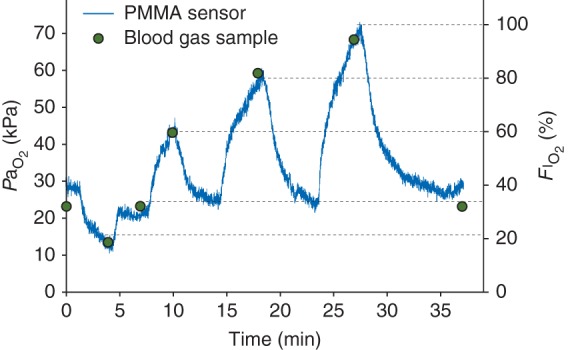
Arterial Po2 responses to FIO2 step changes in one anaesthetized animal (pig) are plotted against time (sampling rate=10 Hz). The blue line shows PaO2 recorded by the PMMA sensor, the circles show results from arterial blood gas sampling at 0, 4, 7, 10, 18, 27, and 37 minutes; FIO2 at these time points was 21, 35, 60, 80, 100, and 35% respectively. The dotted horizontal lines highlight the FIO2 values at the time when blood samples were taken.